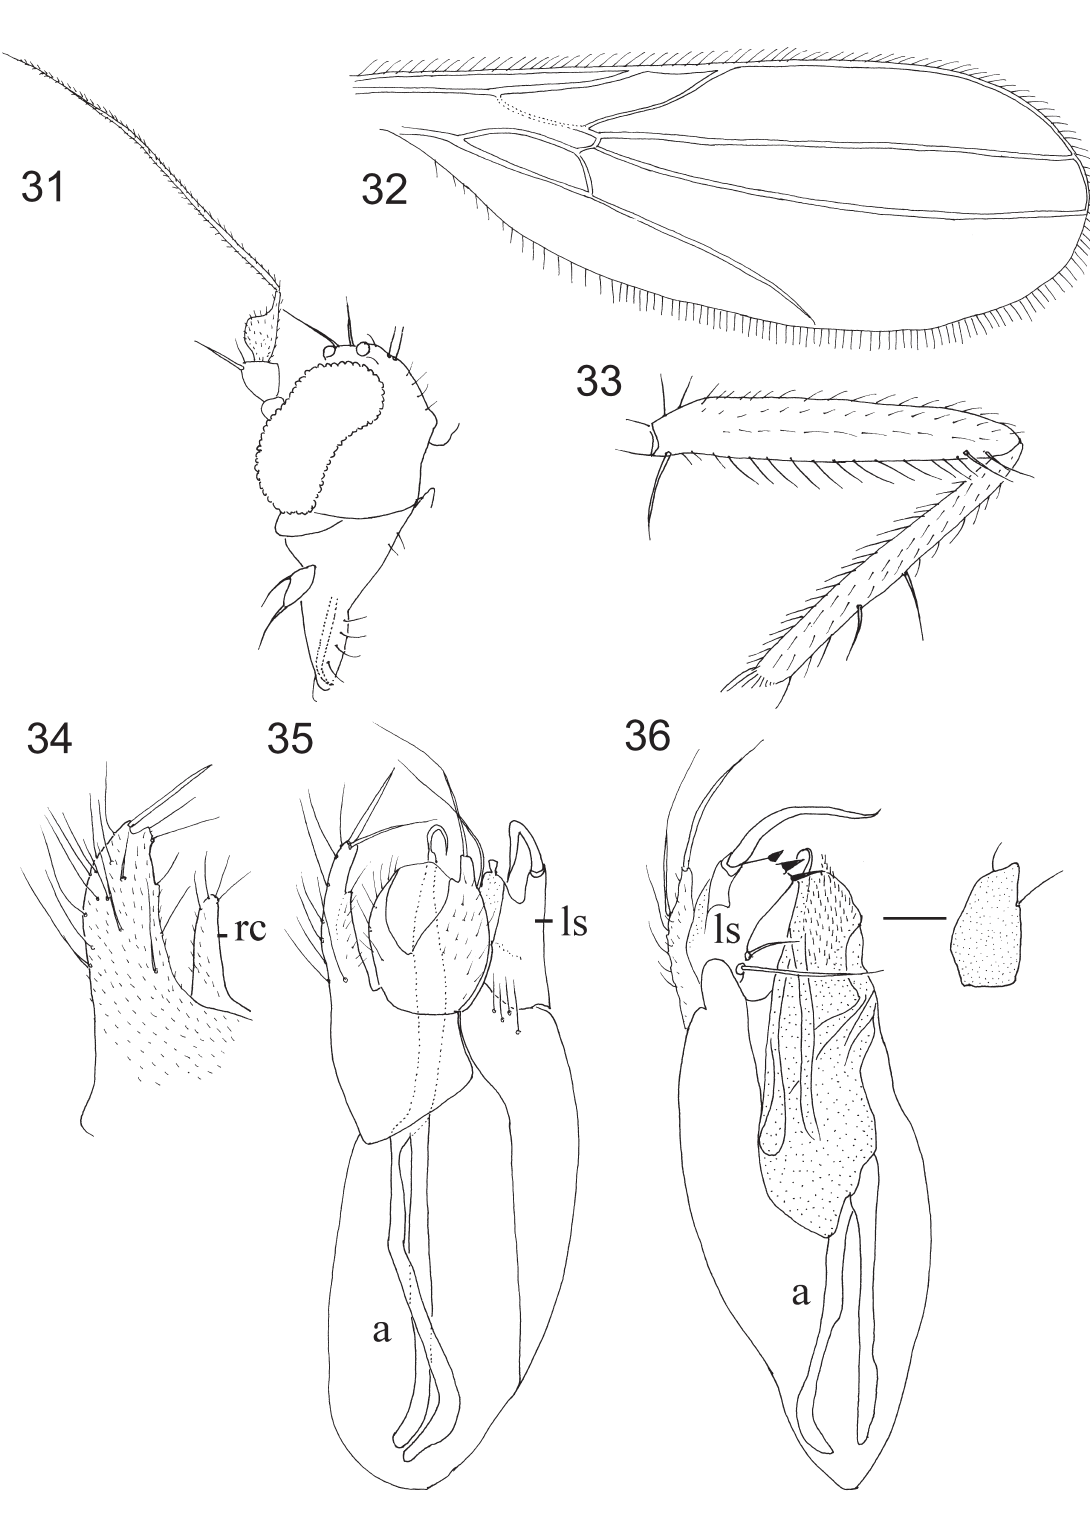
Figs 31-36. Chersodromia bulohensis sp. nov., ♂. 31 . head, lateral view. 32 . wing, dorsal view. 33 . hind femur and tibia, anterior view. 34 . right epandrial lamella, lateral view. 35 . epandrium with cerci, dorsal view. 36 . hypandrium with detail of left surstylus, ventral